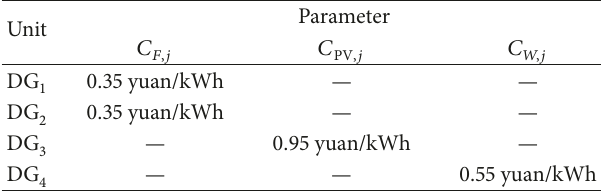
Table 1: Parameter values of the DG units in the MG.